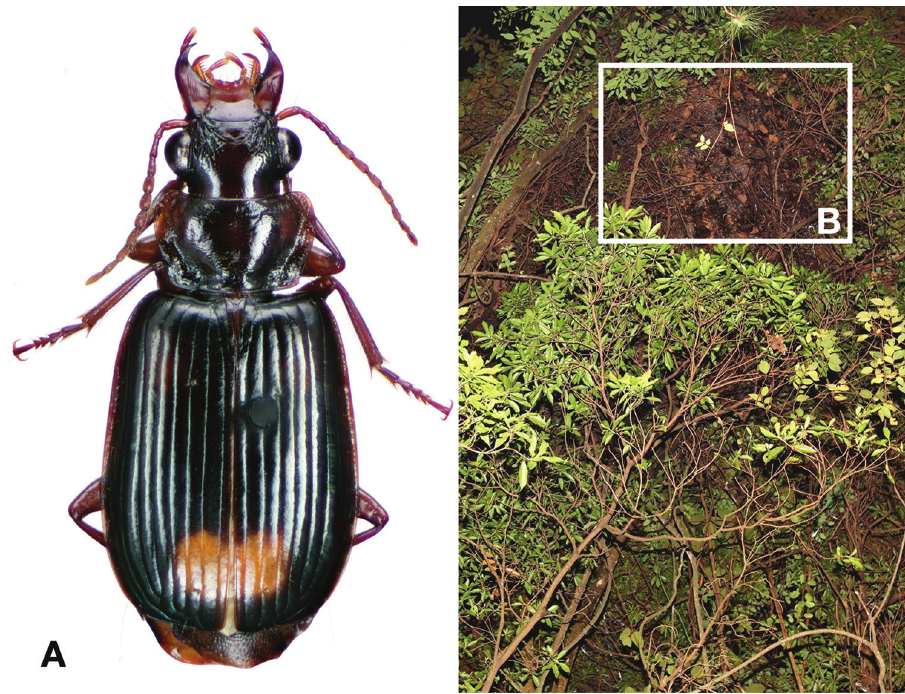
Figure 82. A Dorsal habitus and color pattern of Horniulus andrewesi Jedlička. (OBL 10.20 mm). B mixed forest dead leaf mass where several specimens were collected by insecticidal